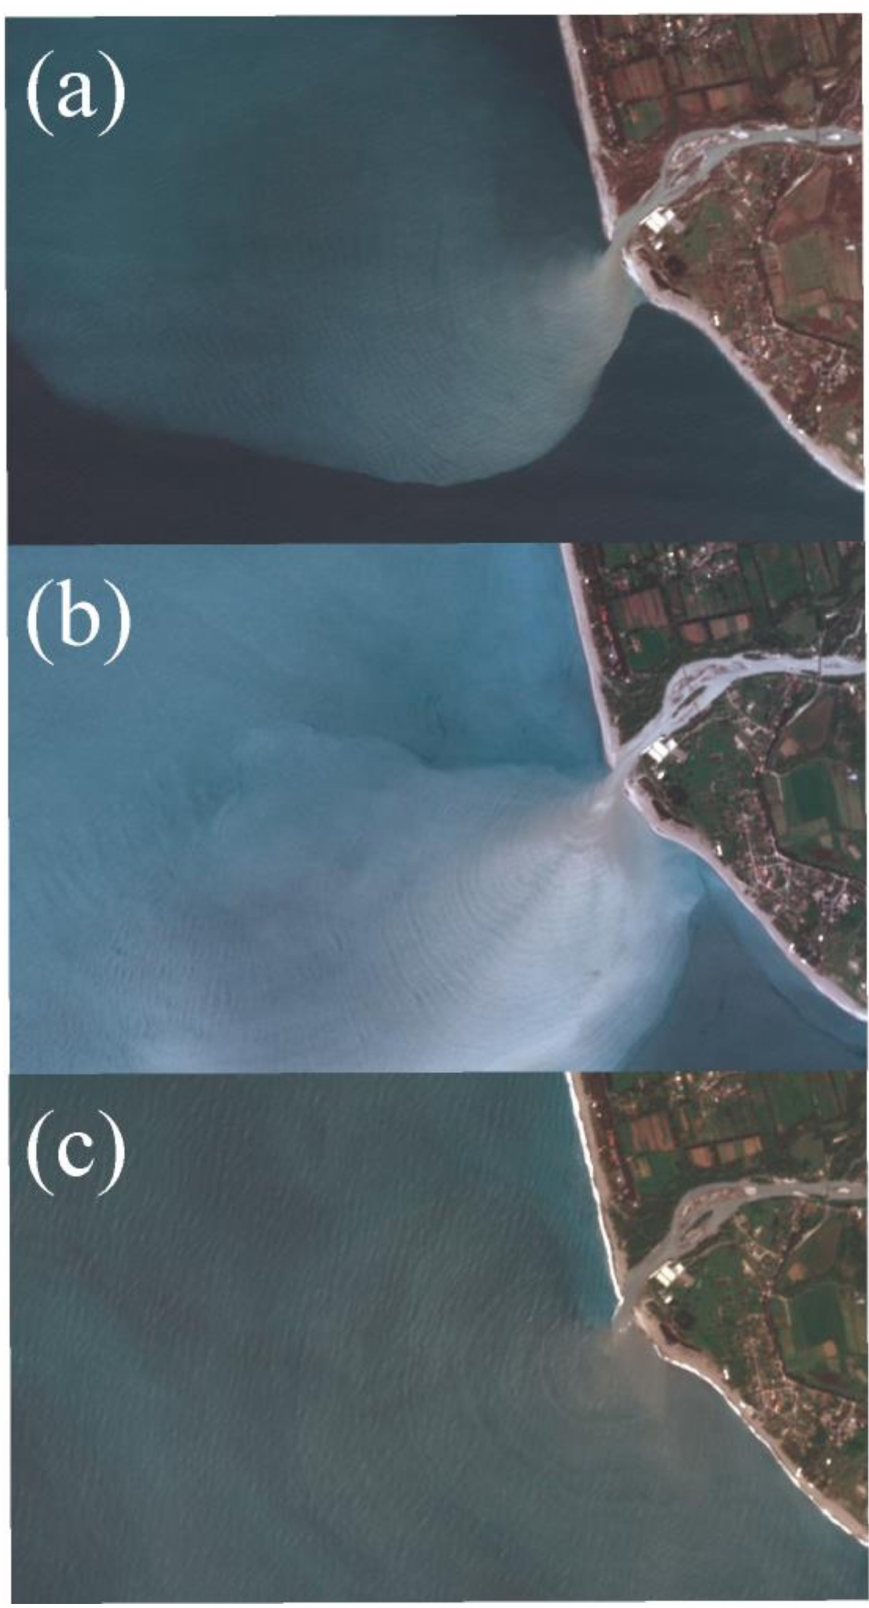
Figure 2. Satellite images (Sentinel-2) of the Bzyb plume with distinct ring-like features acquired